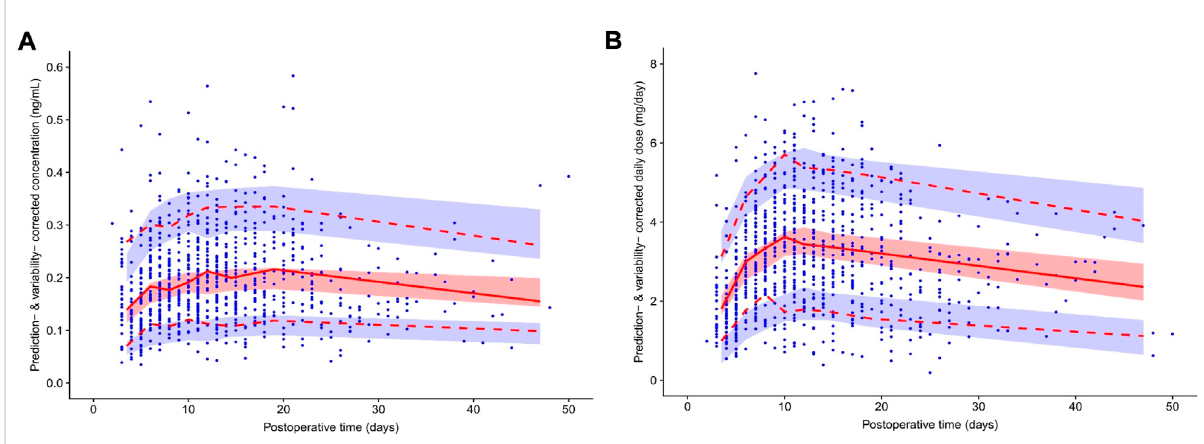
FIGURE 2 Prediction-and variability-corrected visualpredictivecheck(pvcVPC) plotof thetheory-based fi nal model plot (A) and fi nalMM modelplot (B) . The red solid line represents the prediction- and variability-corrected median observed concentration, and the semitransparent red shaded area representsthesimulation-based95%con fi denceintervals(CIs)forthemedian.Thereddashedlinesrepresentthecorrectedobserved10thand90th percentiles, and the semitransparent blue shaded areas represent the simulation-based 95% CIs for the corresponding predicted percentiles from the fi nal model. The blue dots represent the prediction- and variability-corrected observations.